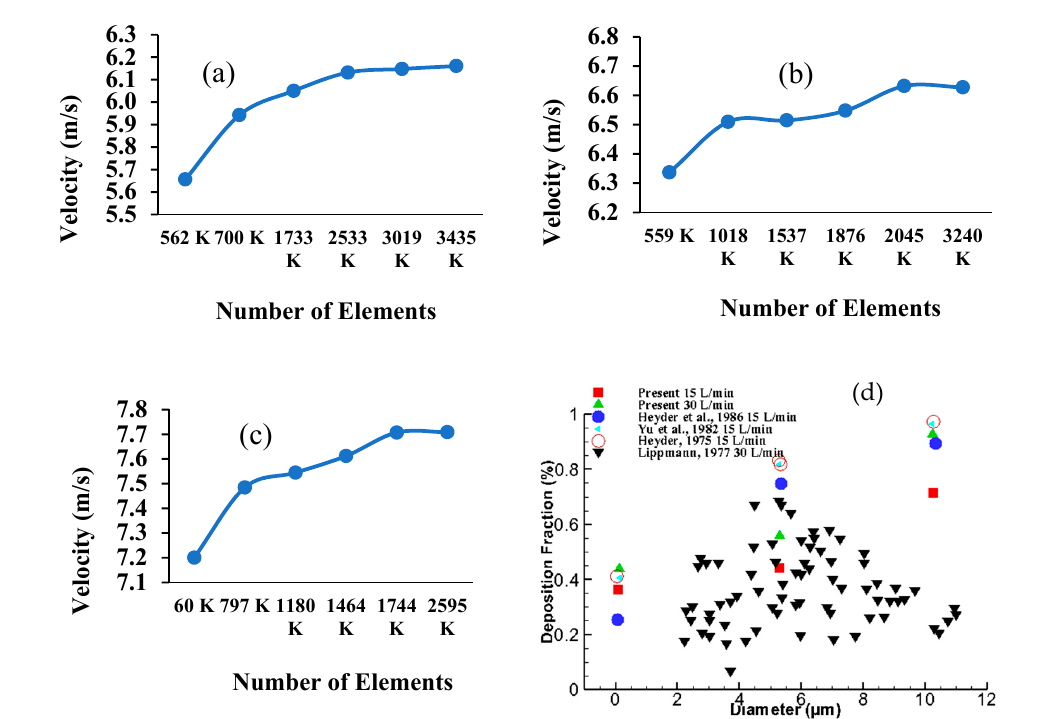
Figure 2. Unstructured mesh for selected sections of the airway model; ( a ) mesh for the whole lung model (cells invisible because of a large number of small cells), ( b ) tetrahedral elements for the mouth-throat section, ( c ) the mesh at a bifurcation branch, and ( d ) inflation mesh at the inlet cross- section of the mouth area.